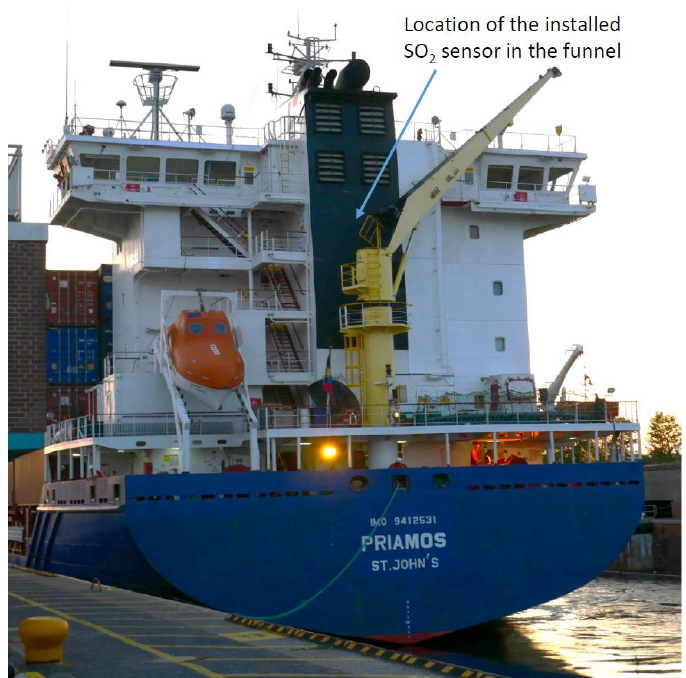
Figure 8. The container ship PRIAMOS with the approximate location of the installed and newly developed photoacoustic SO 2 sensor.